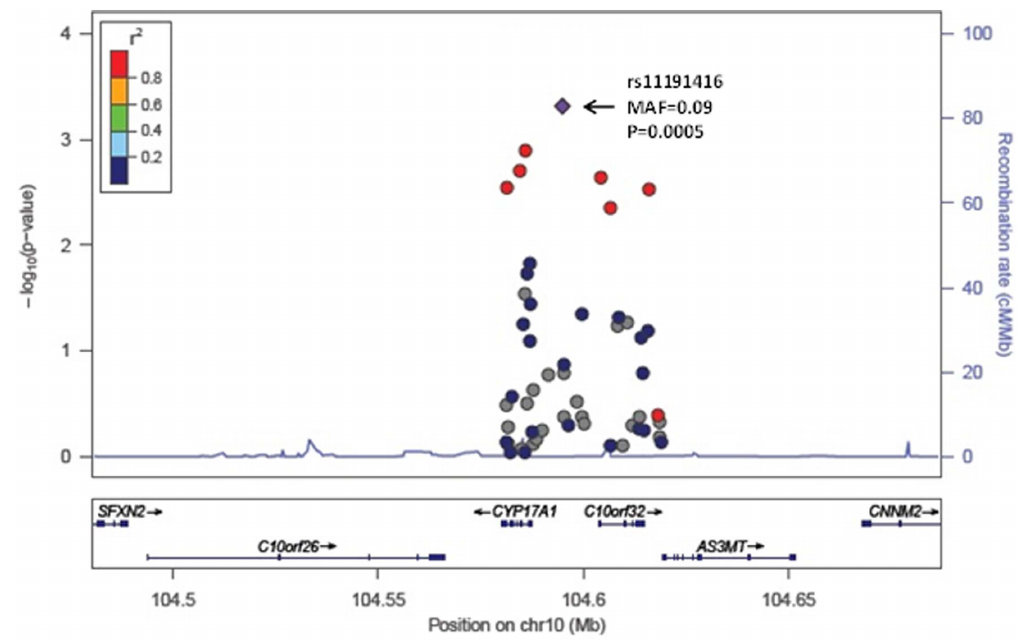
Figure 2. Regional association plot for CYP17A1 in relation to SBP. Each circle represents a single variant. The triangle denotes the index variant. The color coding corresponds to the correlation (r 2 ) between index variant and the other variants.